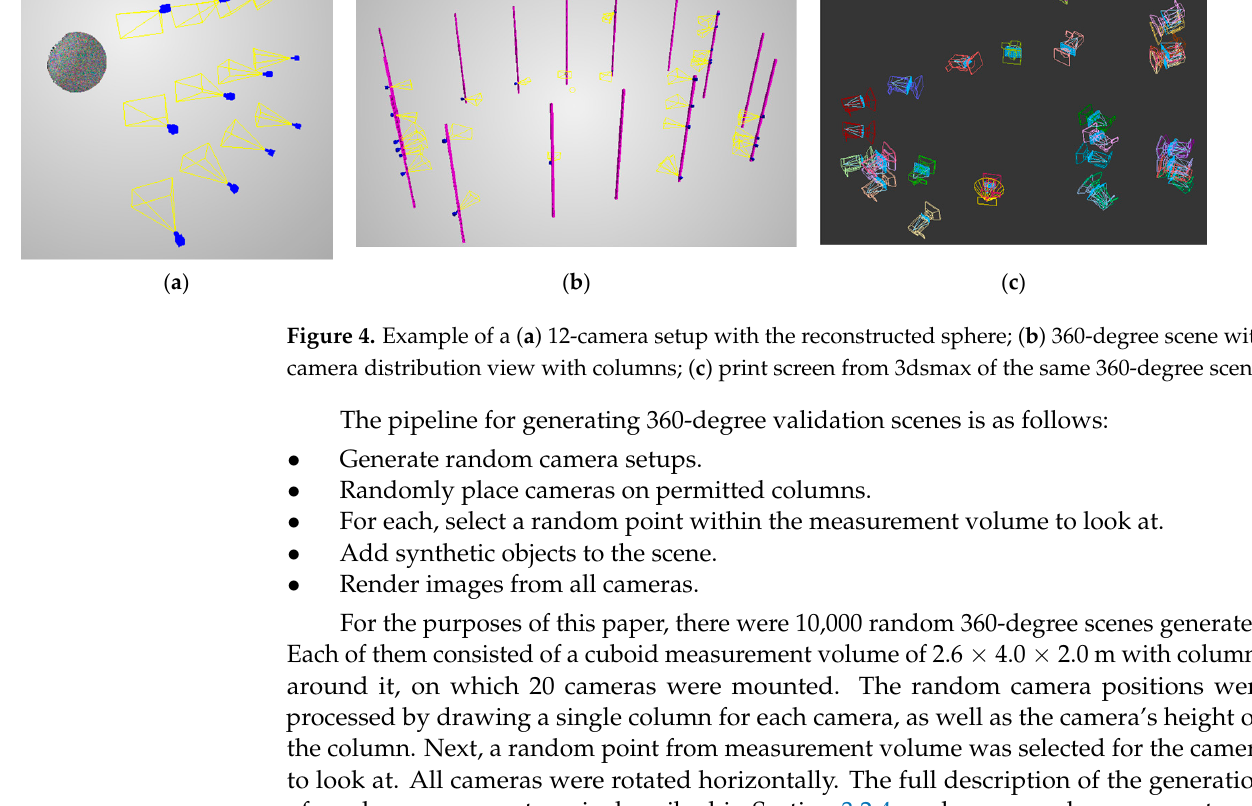
( c ) Figure 3. Example ( a ) sphere reconstruction from a two-camera scenario; ( b ) the results of density computation (points/mm 2 ); ( c ) accuracy evaluation (mm). The first dataset consisted of setups with 2, 3, 4, 6, 9, or 12 cameras, respectively, placed on the XY plane at distances of 1 m in different configurations, with the sphere positioned at four distances on the Z -axis. In the two-, three-, and four-camera setups, the cameras were arranged in a single horizontal row; the six-, nine-, and twelve-camera set- ups were formed in 2 × 3, 3 × 3, and 4 × 3 camera arrays, respectively. For each scenario, the sphere was positioned at the following distances from the camera array plane: 2, 3, 4, and 5 m, in two variants each: on the cameras’ symmetry axis and off the symmetry axis. This resulted in 48 reconstructed spheres in total. As an example, the reconstructed sphere from the 12-camera scenario are presented in Figure 4a. The pipeline for generating 360-degree validation scenes is as follows: •